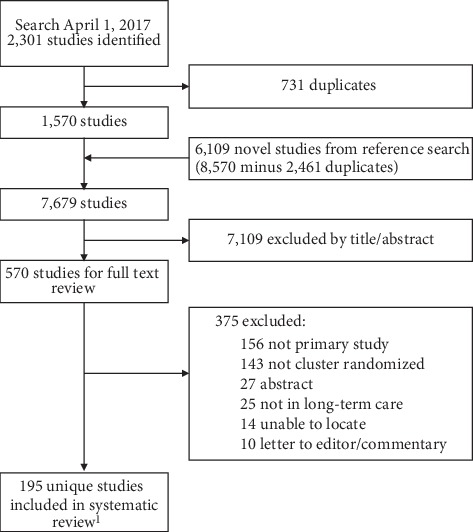
PRISMA flow diagram. 1195 Studies = 142 studies (from original review) + 53 studies (review of citations).